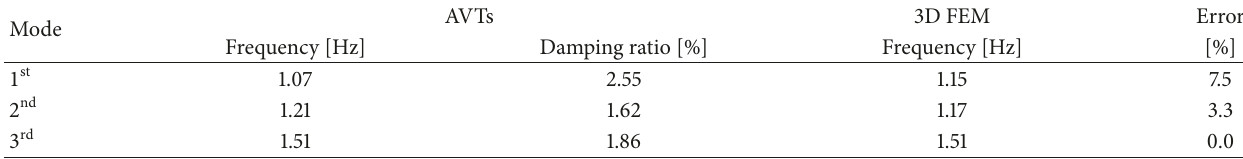
Table 1: Numerical and experimental first three eigenfrequencies and damping